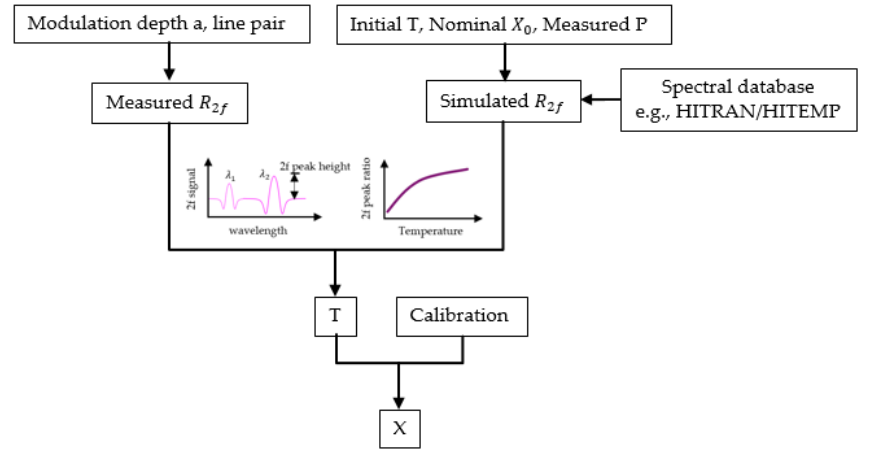
Figure 4. Flowchart of the 2 f -WMS method.